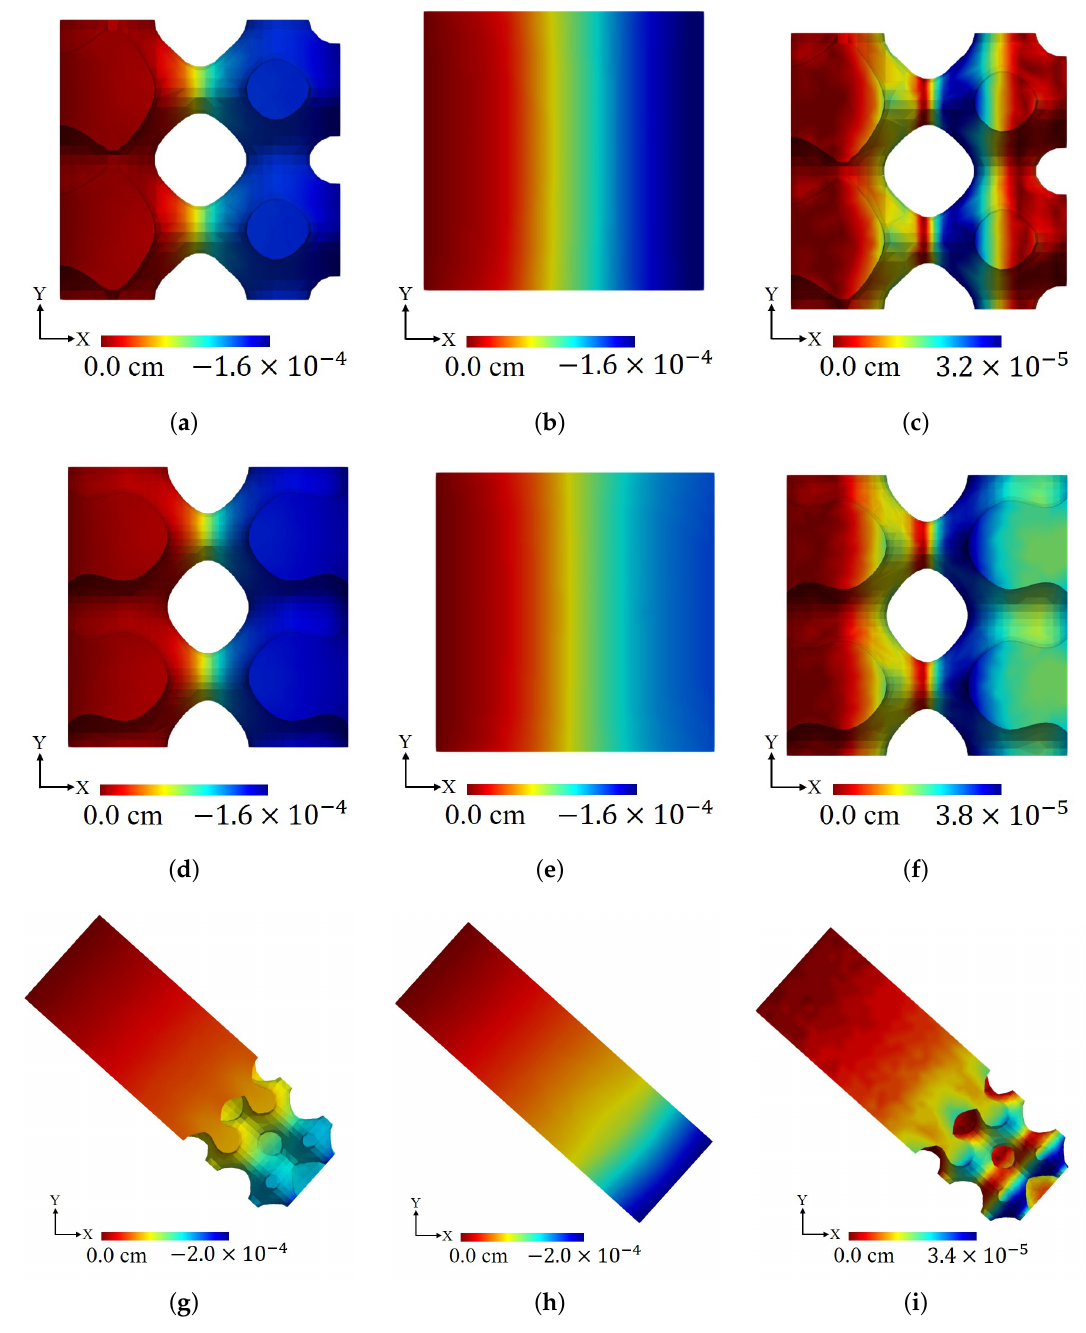
Figure 8. Results of X compression test. Domains of graded density of 8 and 24 cells. Domain of density per Equation (9): ( a ) X displacement in lattice domain. Min. displacement: − 1.6 × 10 − 4 cm; ( b ) X displacement in homogeneous domain. Min. displacement − 1.6 × 10 − 4 cm; and ( c ) absolute error. Domain of density per Equation (10): ( d ) X displacement in lattice domain. Min. displacement: − 1.6 × 10 − 4 cm; ( e ) X displacement in homogeneous domain. Min. displacement − 1.3 × 10 − 4 cm; and ( f ) absolute error. Domain of density as in [7]: ( g ) X displacement in lattice domain. Min. displacement: − 1.8 × 10 − 4 cm; ( h ) X displacement in homogeneous domain. Min. displacement − 2.0 × 10 − 4 cm; and ( i ) absolute